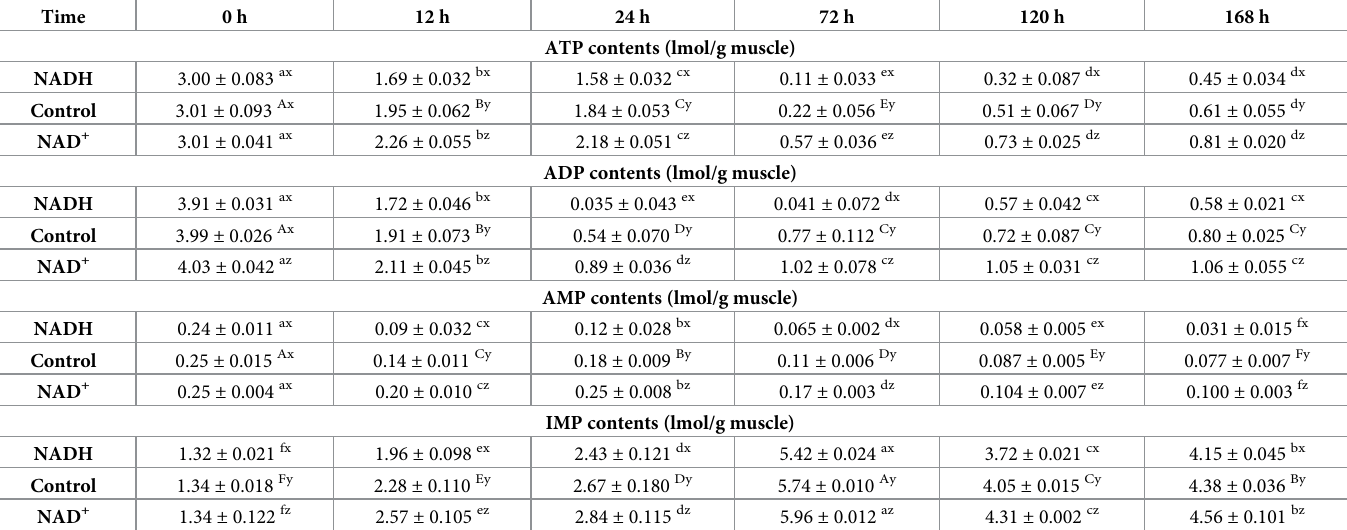
Table 2. Nucleotide concentrations in postmortem yak longissimus thoracic muscle.